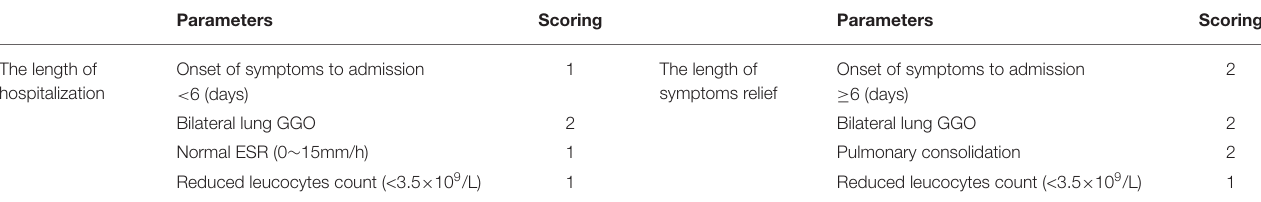
TABLE 7 | The scoring criteria for the length of hospitalization and symptoms relief.